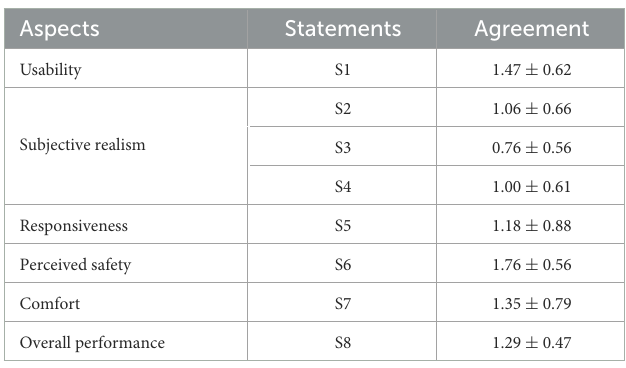
TABLE 1 Results of subjective evaluation of PREDICTOR from different